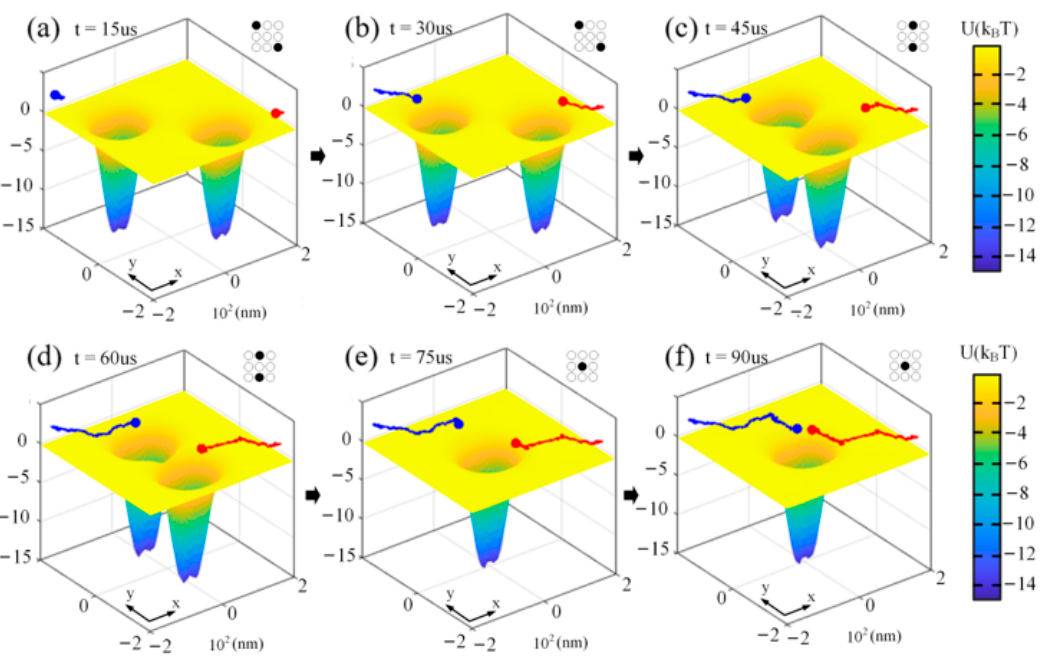
Figure 6. Trajectories of two nanoparticles (blue and red) in a 3 × 3 graphene disk array, and a color map of the trapping potential. The blue line and the red line are the real-time movement tracks. The circular array corresponds to the switching state of the 3 × 3 graphene disc array, the solid circle corresponds to the ON state, and the hollow circle corresponds to the OFF state. ( a – f ) are trajectories in different switch configurations and at different times, 15, 30, 45, 60, 75, and 90 us, respectively.